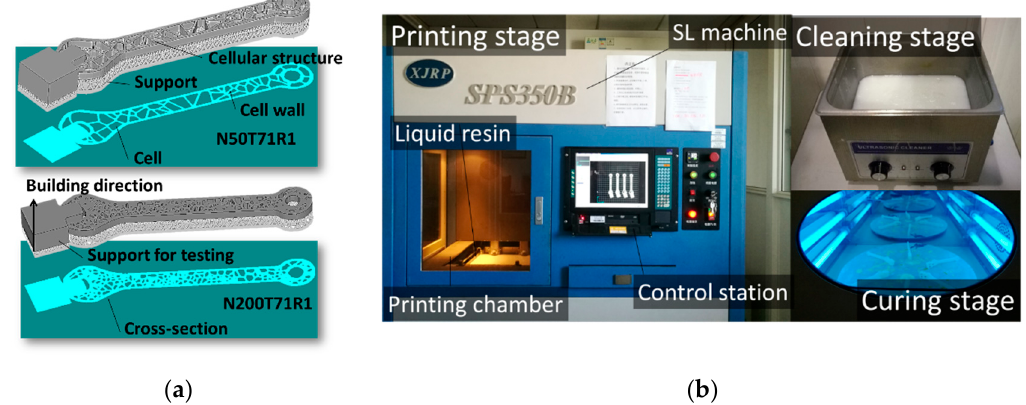
Figure 2. ( a ) Example of two CAD (Computer-Aided Design) models representing cellular designs of a wrench and their conversion into sliced objects for stereolithography. Sample nomenclature includes number of seed points N , relaxation time T and replicate number R, ( b ) Main steps of manufacturing using stereolithography equipment.